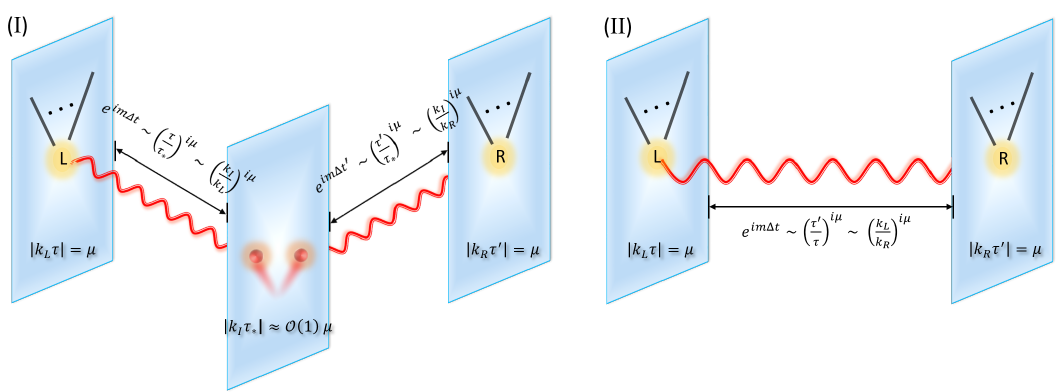
Figure 2 . Illustrations of the physical interpretation of two different types of CC signals, (I) shows the non-local type and (II) is the local type. The planes indicate events happening at different locations in spacetime. In both cases, the dynamical phases accumulated between the events are encoded as oscillations in momentum